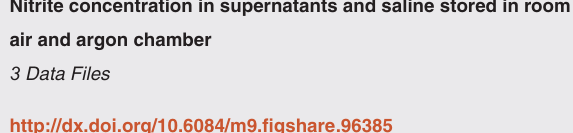
Nitrite concentration in supernatants and saline stored in